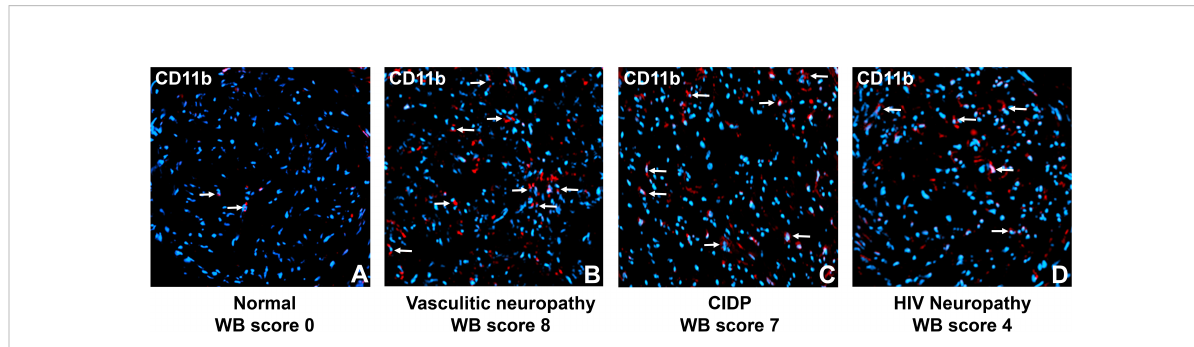
FIGURE 6 Sural nerve endoneurial CD11b+ leukocytes in peripheral neuropathies associated with chronic pain. Representative digital photomicrographs shows CD11b+ leukocyte expression (white arrows) in three adult patients with chronic pain (B-D) contrasted with a histologically normal nerve biopsy (A) . Nuclei are shown in blue (DAPI). Original magni fi cation